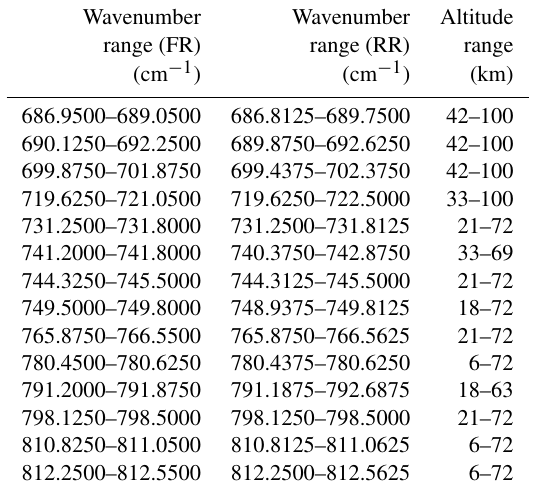
Table 2. Microwindows of the combined MIPAS temperature and tangent altitude retrieval for the full (first column) and reduced (sec- ond column) spectral